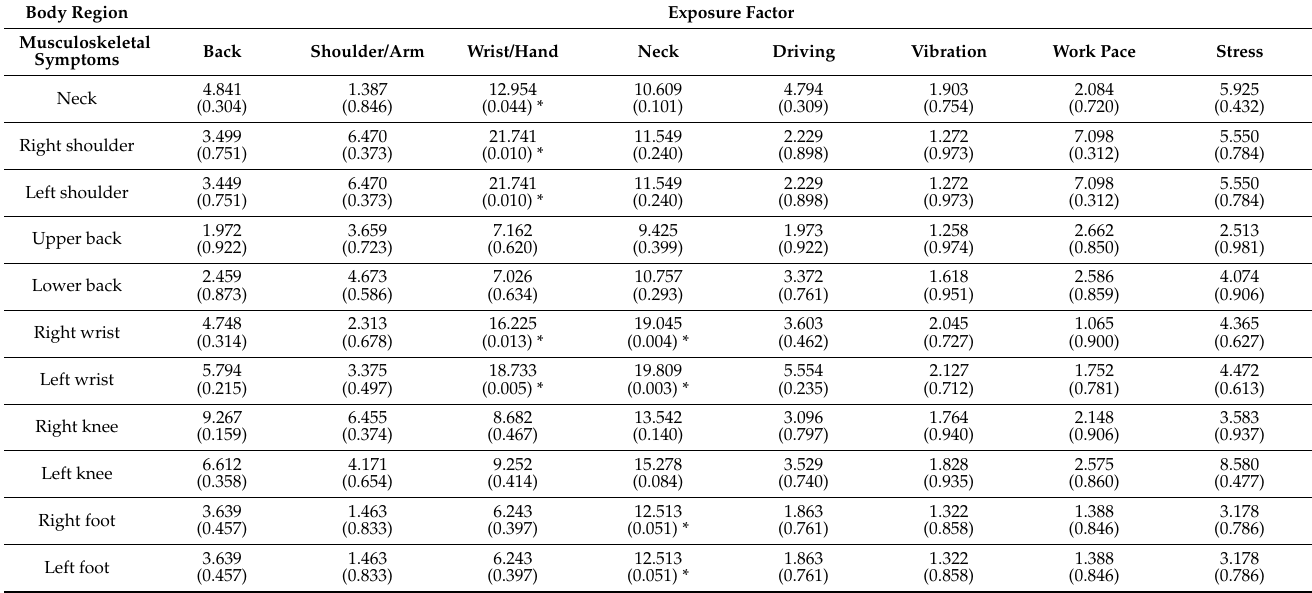
Table 13. Pearson chi-square test musculoskeletal symptoms by QEC method exposure level.